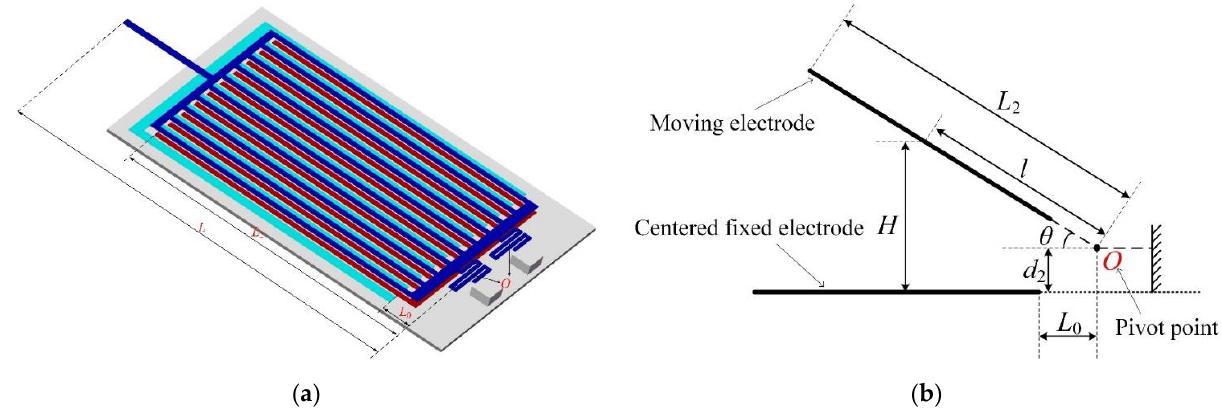
Figure 11. Principle view of the torque generated in the electrostatic repulsive actuator. ( a ) Dimension diagram of microgripper; ( b ) Side view of the electrostatic repulsive actuator.